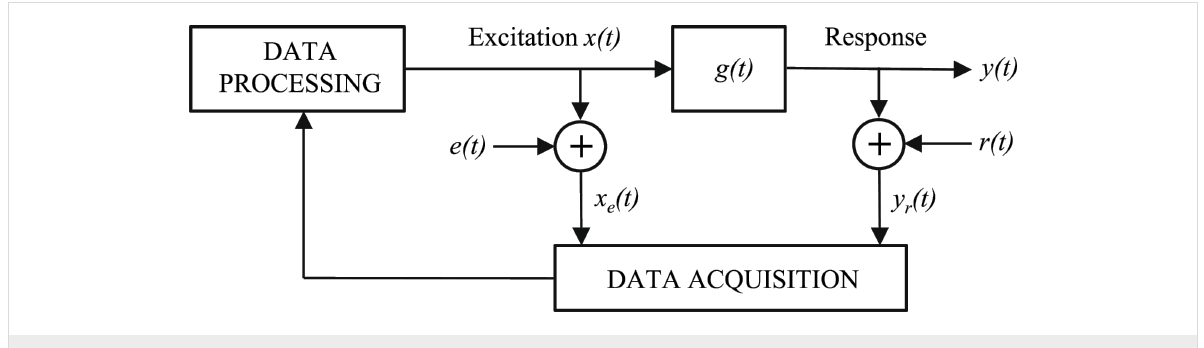
Figure 2: Typical measurement